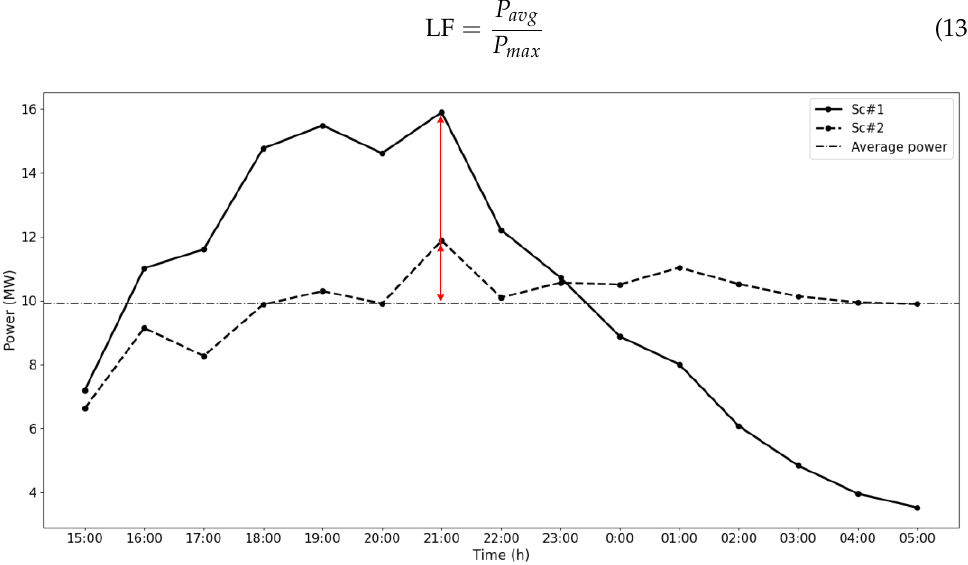
Figure 9. Load curves of the total hourly power demand.